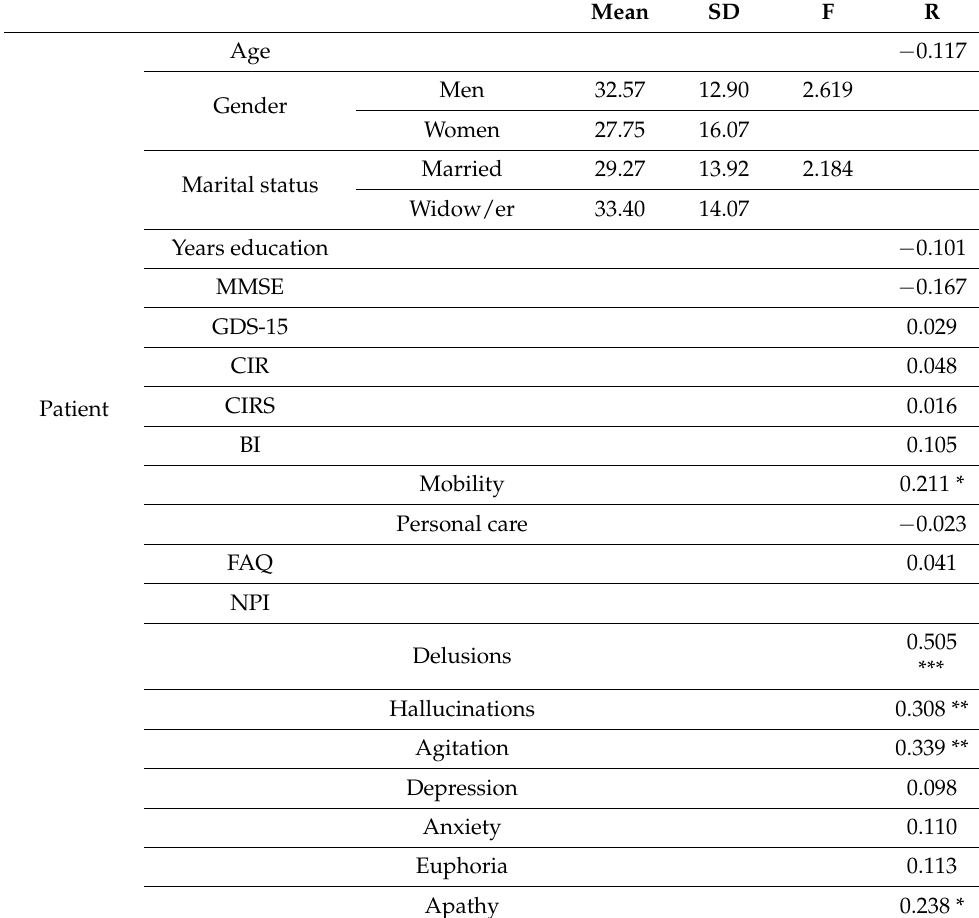
Table 2. Association analyses between patients and caregivers’ factors and